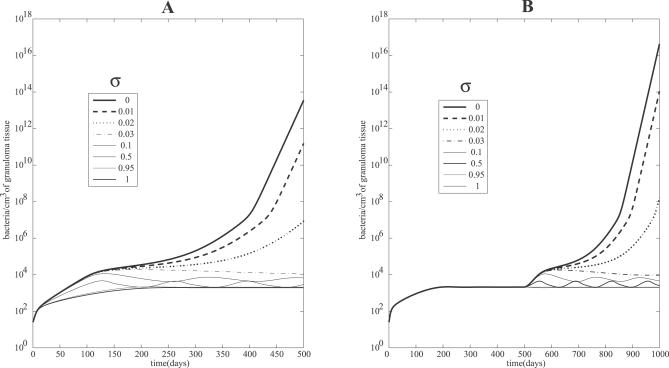
Comparing the Roles of sTNF and tmTNF(A) Mathematical model simulations of total bacterial load corresponding to different proportions σ (percent sTNF versus tmTNF); all the other parameters are fixed to parameters yielding a latent state (see Table S6).(B) Simulated depletion of variable levels of sTNF. Until day 500, the system is in latency and σ = 0.95. Then at day 500, the depletion of sTNF is performed. Different values of σ are shown, where σ is the percent cleaved TNF (sTNF). Total bacterial loads are shown corresponding to different percentages of sTNF after day 500.